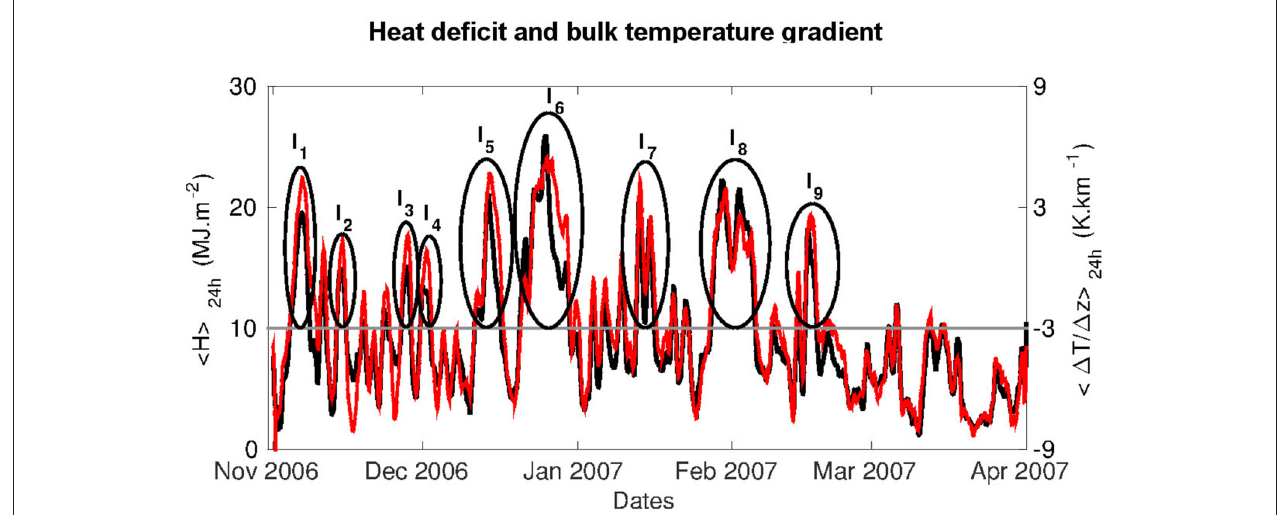
FIGURE 3 | Temporal evolution of the 24-h-running average of the bulk temperature gradient 1 T /1 z (red) and heat deficit H (black) during the 2006–2007 winter. The 9 inversions I k , 1 ≤ k ≤ 9, detected by criterion (1) are circled in black. The persistence threshold h 1 T /1 z i winter is indicated with a gray line. Extracted and adapted from Largeron and Staquet (2016).